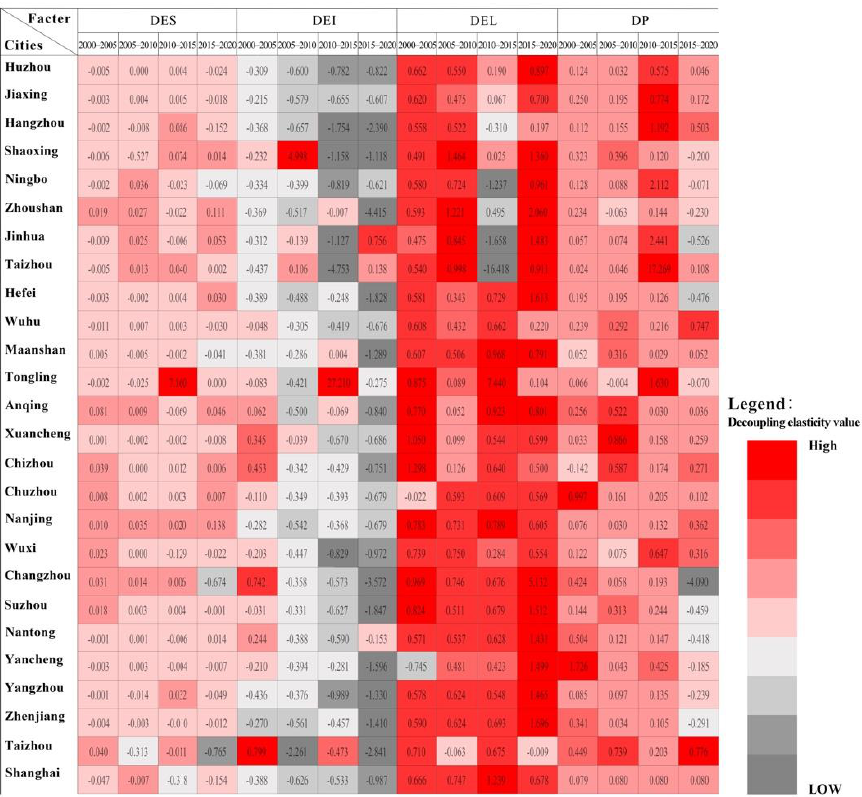
Figure 8. Decomposition of influencing factors of decoupling carbon emissions in prefecture-level cities in the YRD from 2000 to 2020.